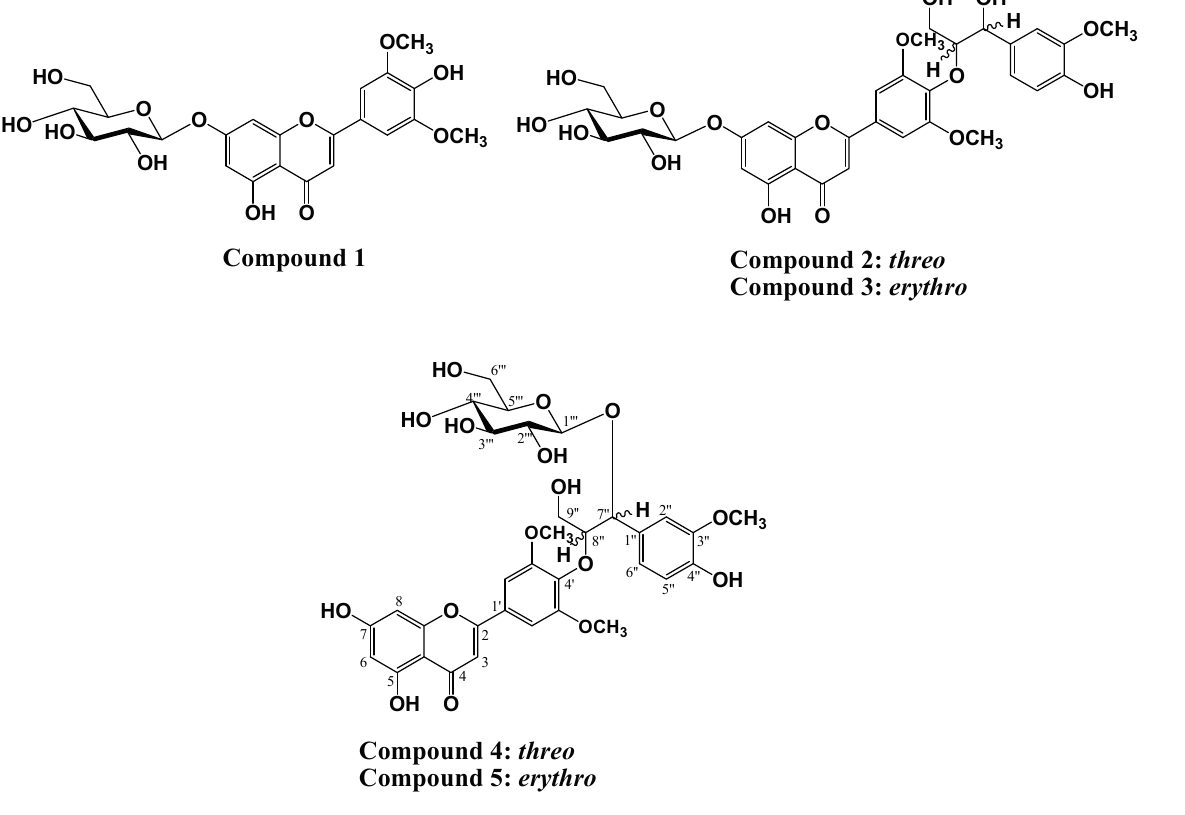
Figure 1. Chemical structures of isolated compounds 1 – 5